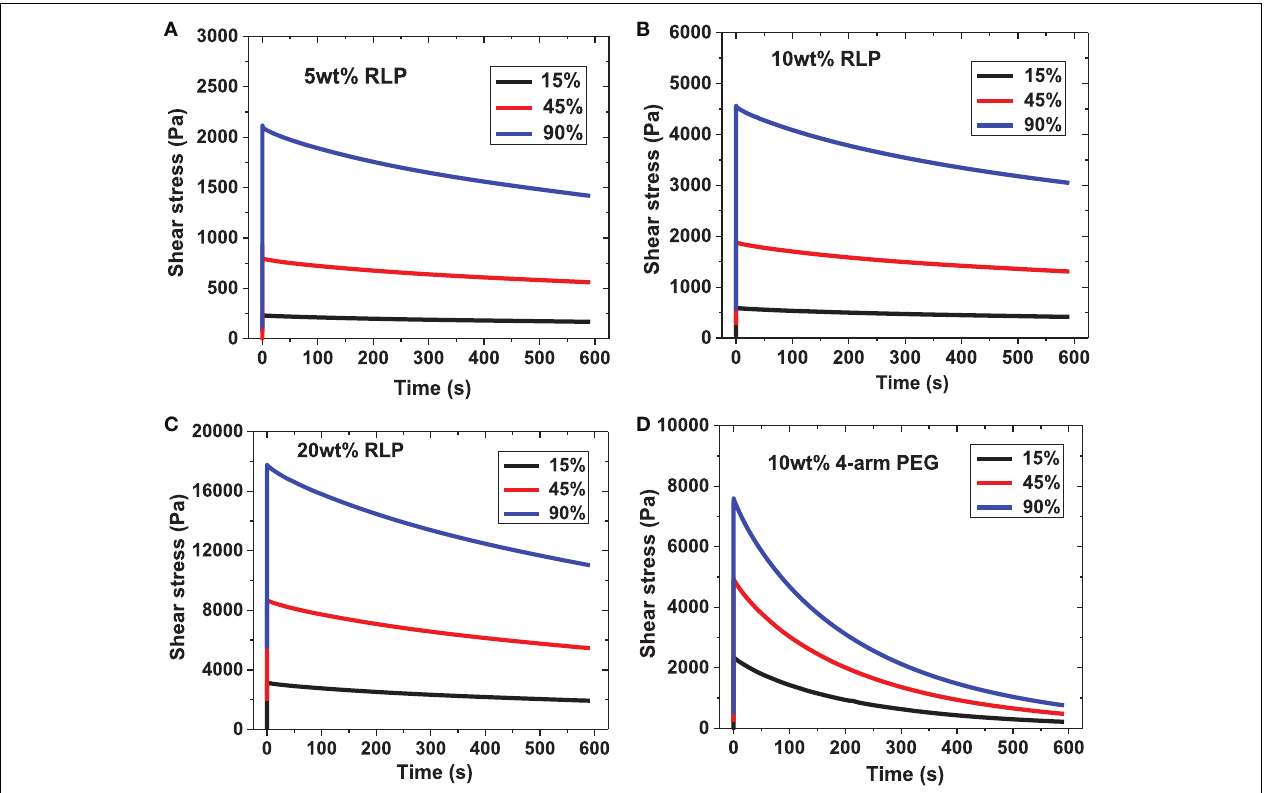
FIGURE 4 | Representative oscillatory stress relaxation data. (A) 5 wt% RLP, (B) 10 wt% RLP, (C) 20 wt% RLP and (D) 10 wt% 4-arm PEG cross-linked hydrogels at 15, 45, and 90%